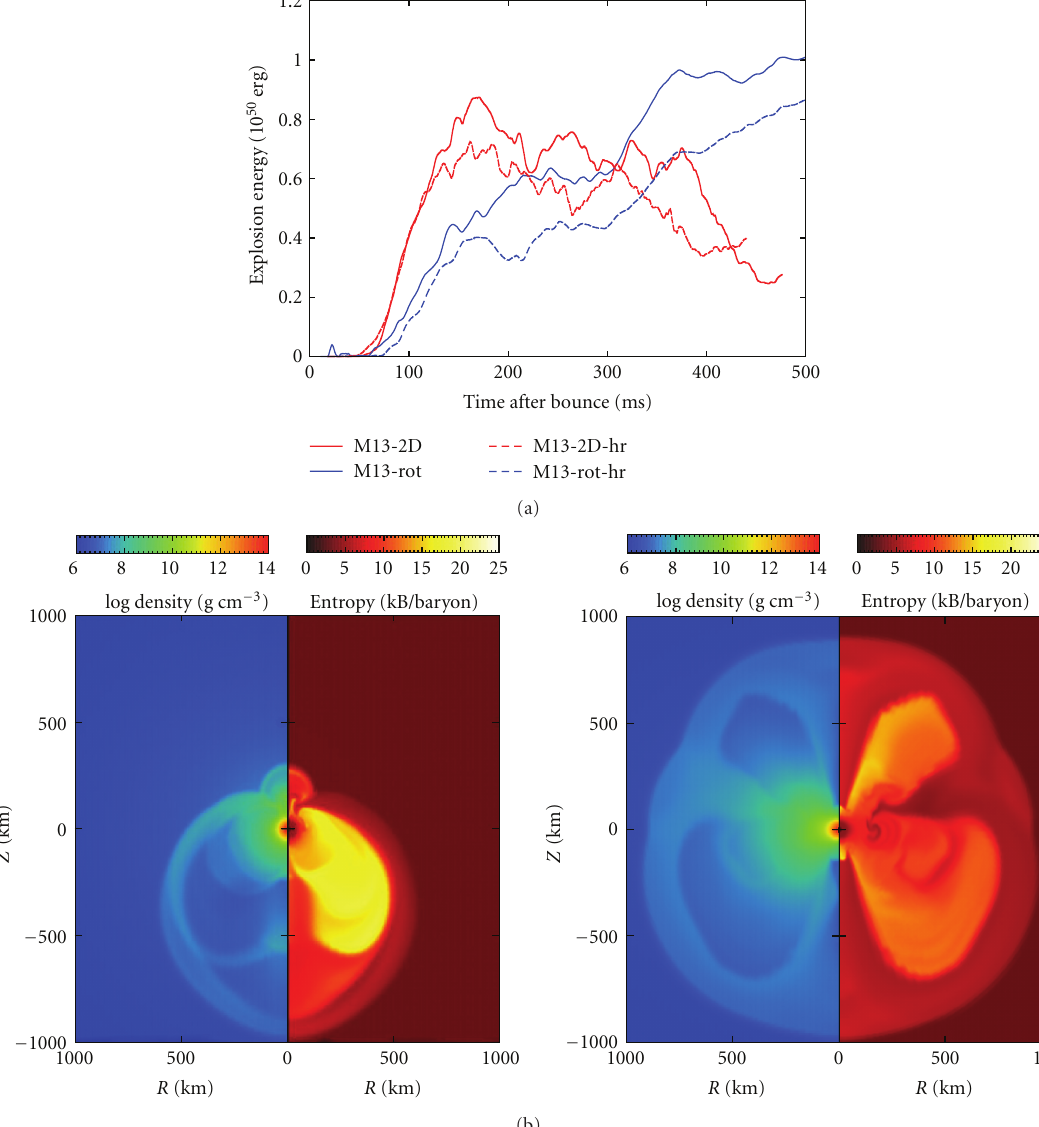
Figure 4: Time evolution of the explosion energy versus postbounce time for 2D models with and without rotation (a). The explosion energy is defined as the total energy (internal plus kinetic plus gravitational), integrated overall matter where the sum of the corresponding specific energies is positive. Models with “-hr” indicate the ones with higher numerical resolution, in which the mesh numbers in the lateral direction are doubled. (b) are snapshots of the density (left half) and the entropy (right half) for 1D (left) and 2D rotating (right) models at the epoch when the shock reaches 1000 km. These figures are taken from